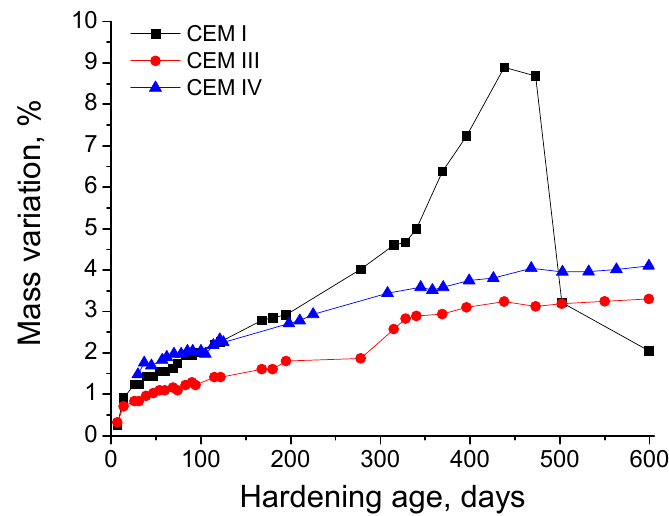
Figure 10. Mass variation (in percentage) observed for CEM I, III and IV grouts in contact with the aggressive medium.